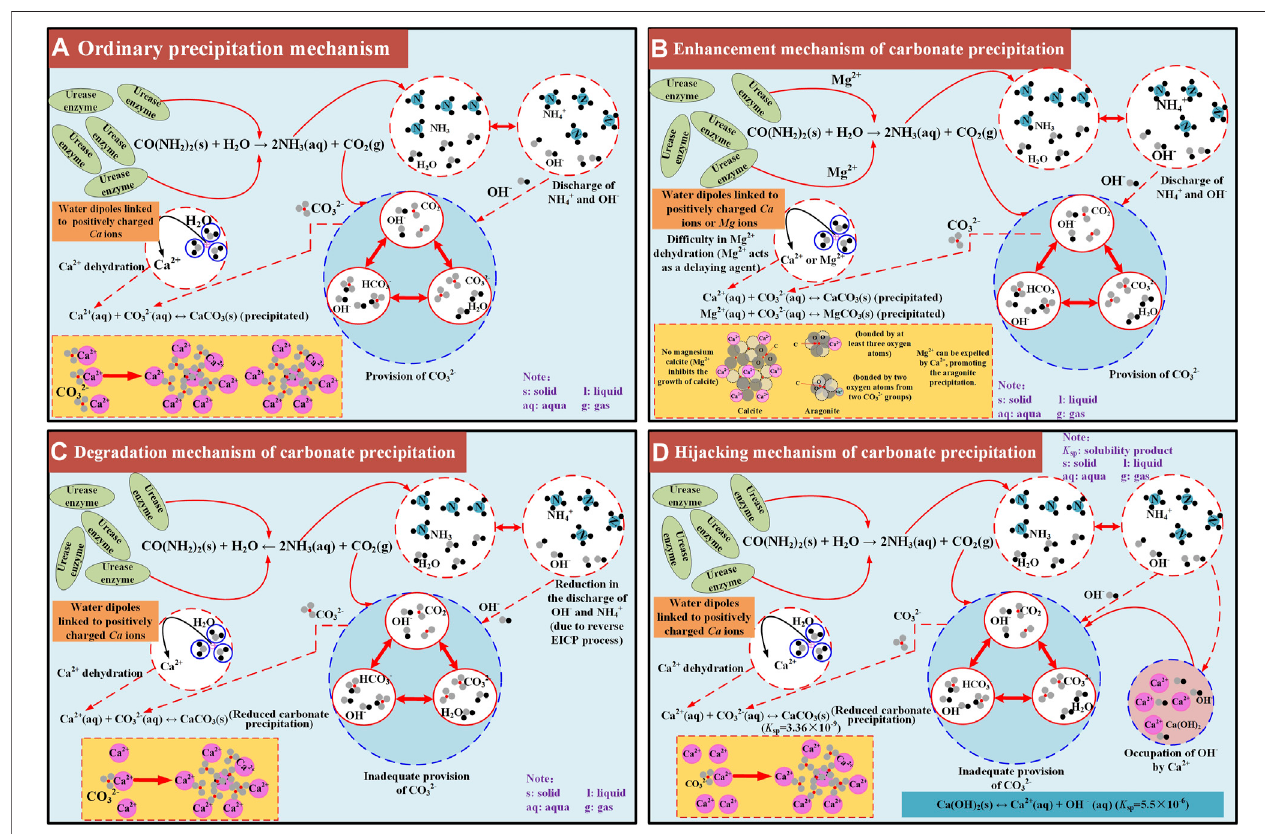
FIGURE 12 | Schematic illustration of the carbonate precipitation mechanisms applied to the ordinary and modi fi ed EICP processes: (A) ordinary precipitation mechanism, (B) enhancement mechanism of carbonate precipitation, (C) degradation mechanism of carbonate precipitation, (D) hijacking mechanism of carbonate